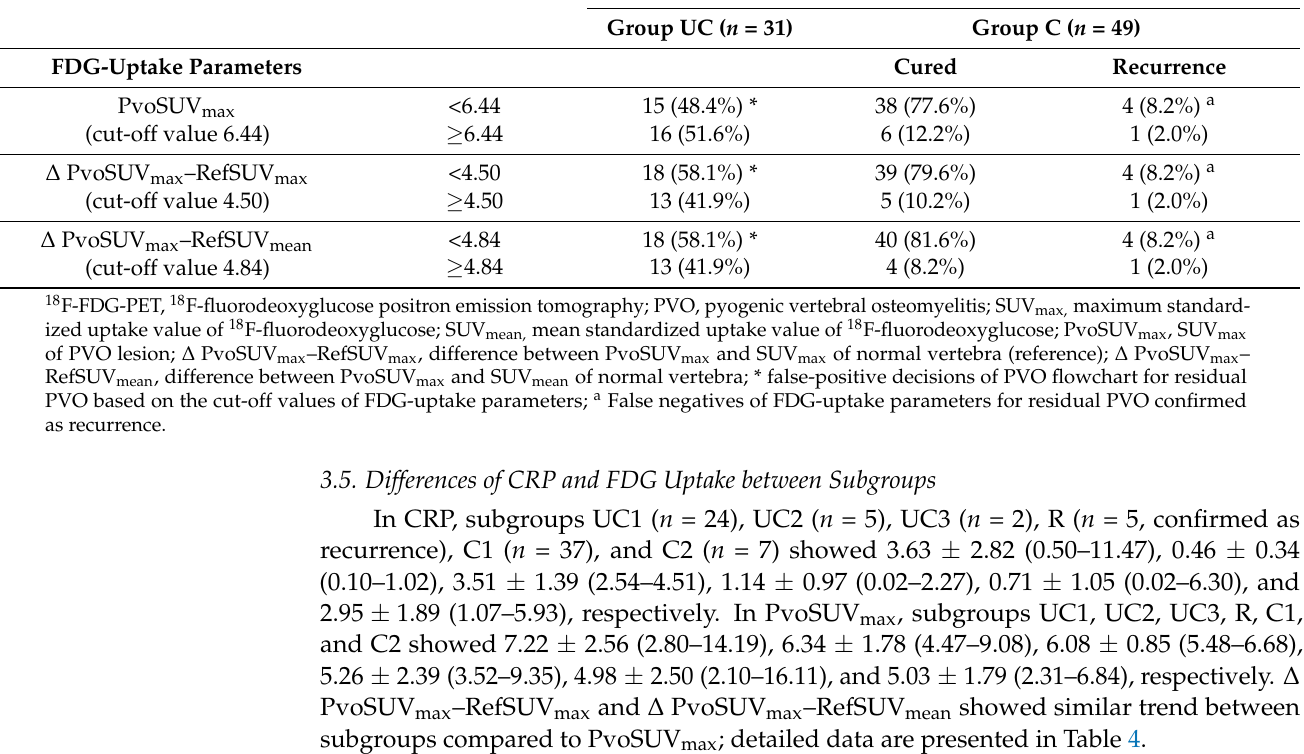
Table 3. Validity of PVO flowchart based on 18 F-FDG-PET. Decisions of PVO Flowchart Group UC ( n = 31) Group C ( n =